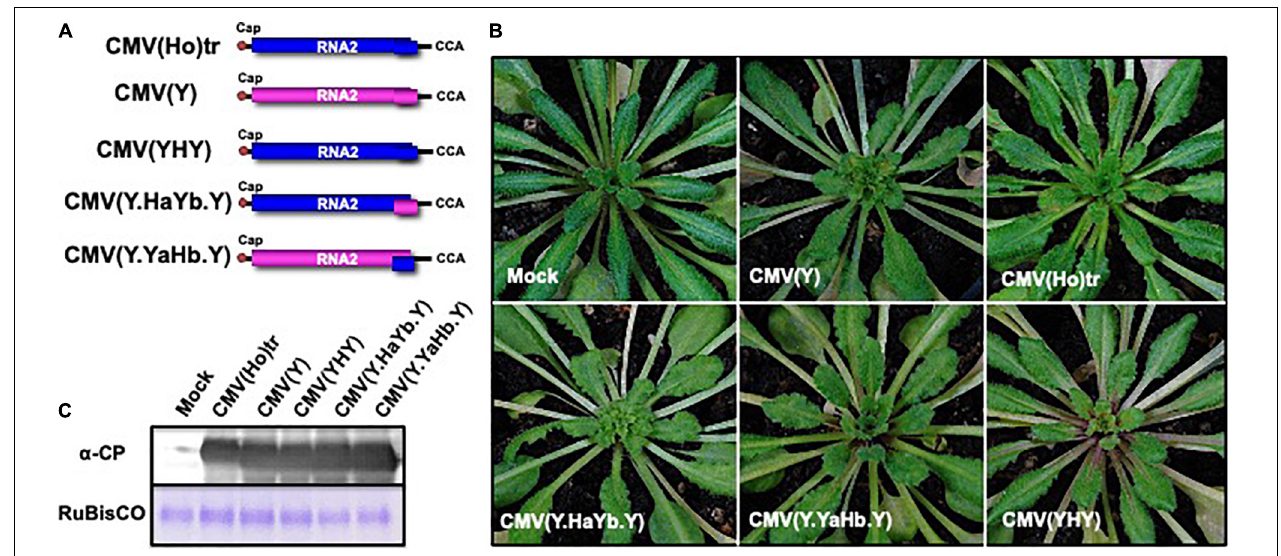
FIGURE 7 | The response of A. thaliana ecotype Col-0 to infection with CMV containing chimeric RNA2 between CMV(Ho)tr and virulent CMV(Y). Fully expanded leaves of Col-0 plants were inoculated with CMV(Y.HaYb.Y) or CMV(Y.YaHb.Y) containing CMV(Y) RNA1 and RNA3 and chimeric RNA2 in which the two open reading frames (ORFs) encoding 2a and 2b proteins were reciprocally exchanged between CMV(Ho)tr and virulent CMV(Y). As a control, Col-0 plants were inoculated with CMV(Ho)tr, CMV(YHY), or virulent CMV(Y), which are shown in Figure 6A . The schematic structures of each CMV RNA2 are shown in (A) . The 5 (cid:48) -end of each RNA has a 7 mGpppG-cap structure (Cap), and the 3 (cid:48) -end of each RNA has the same nucleotide sequence (5 (cid:48) -CCA-3 (cid:48) ). Photographs of young leaves of Col-0 plants infected with CMV(Y.HaYb.Y), CMV(Y.YaHb.Y), CMV(Ho)tr, CMV(YHY), or CMV(Y) at 14 dpi are shown (B) . CMV coat protein in virus-infected leaves was detected immunologically by western blotting (C)